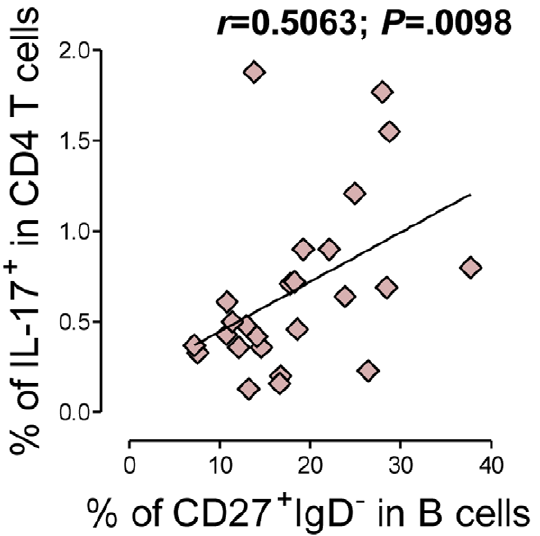
Figure 3. Direct correlation between the frequencies of circulating Th17 cells and switched-memory B cells in healthy individuals. Correlation between the frequencies of switched-memory (CD27 + IgD 2 ) B cells and Th17 cells in healthy individuals. Each symbol represents one healthy individual. Correlation significance was assessed using Spearman coefficient test, and r and P values are shown.